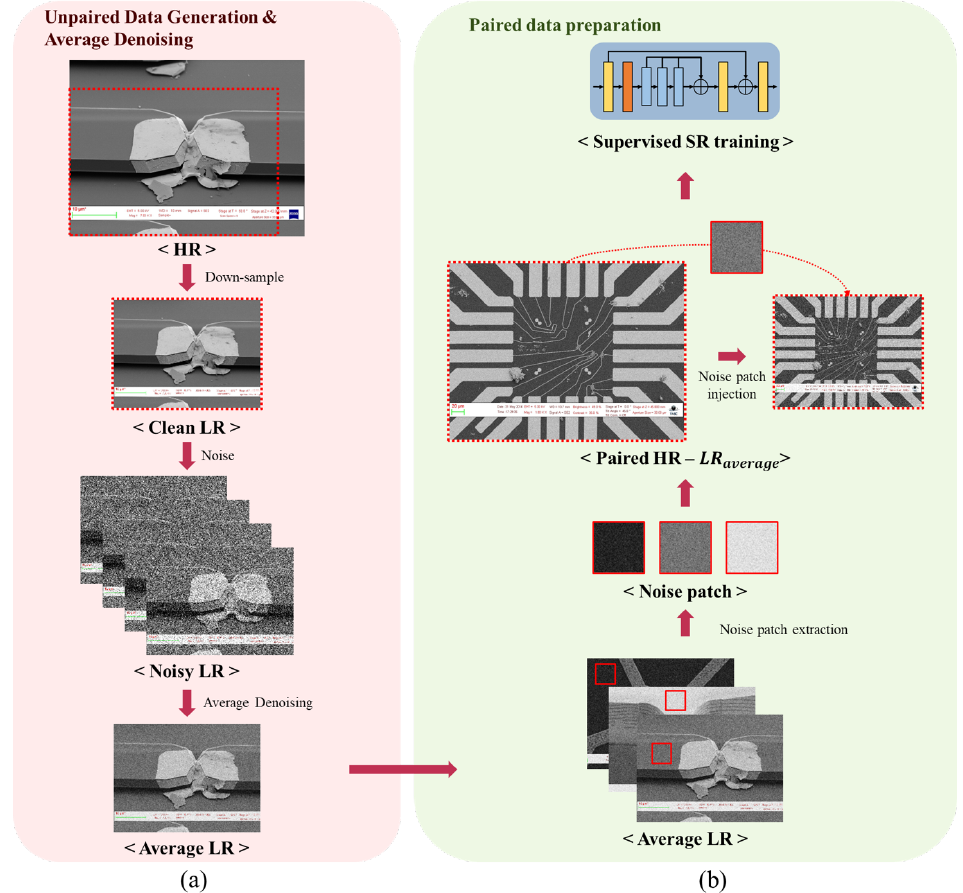
Figure 1. Overall architecture of the proposed method: ( a ) unpaired data generation and average denoising scheme, and ( b ) paired data